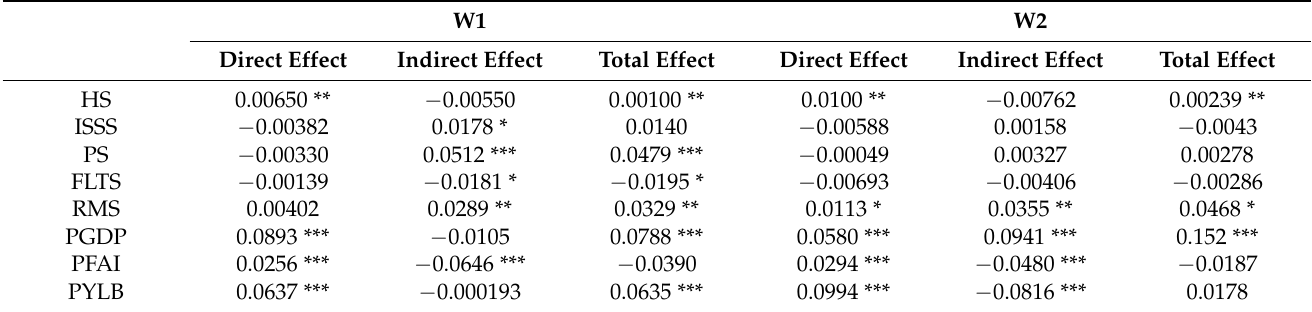
Table 9. Results of spatial spillover partial differential